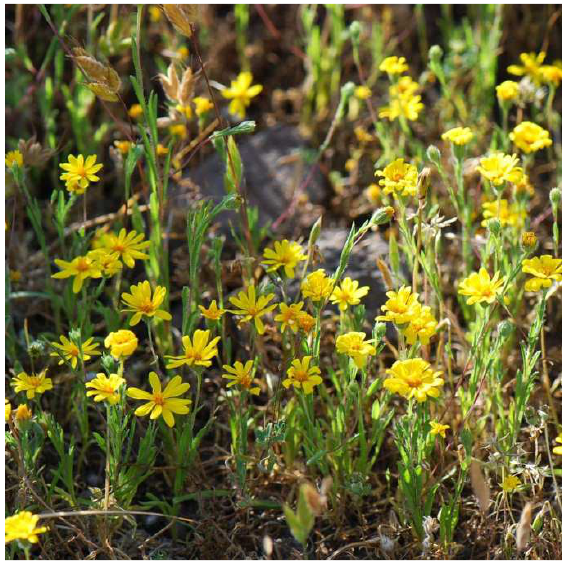
F IGURE 1. Pentachaeta